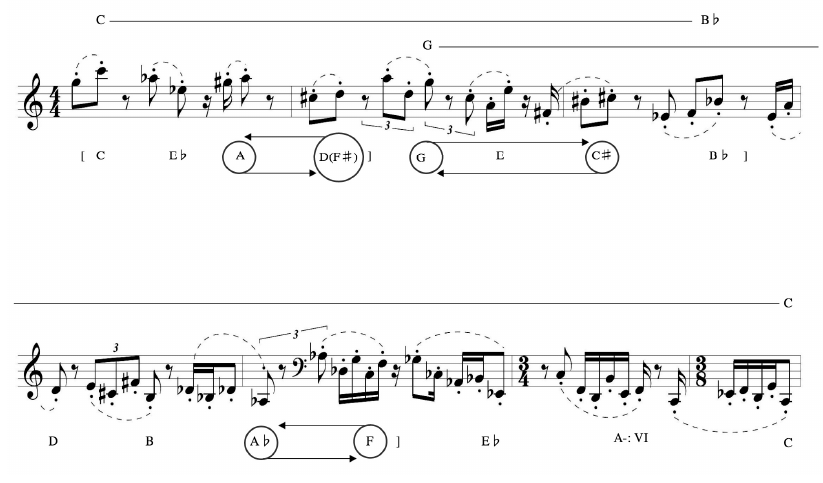
Figure 2. Macklay, Many Many Cadences , measures 7–13, progression of roots of tonicized triads. Figure 2. Macklay (2014) Many Many Cadences , measures 7–13, progression of roots of tonicized